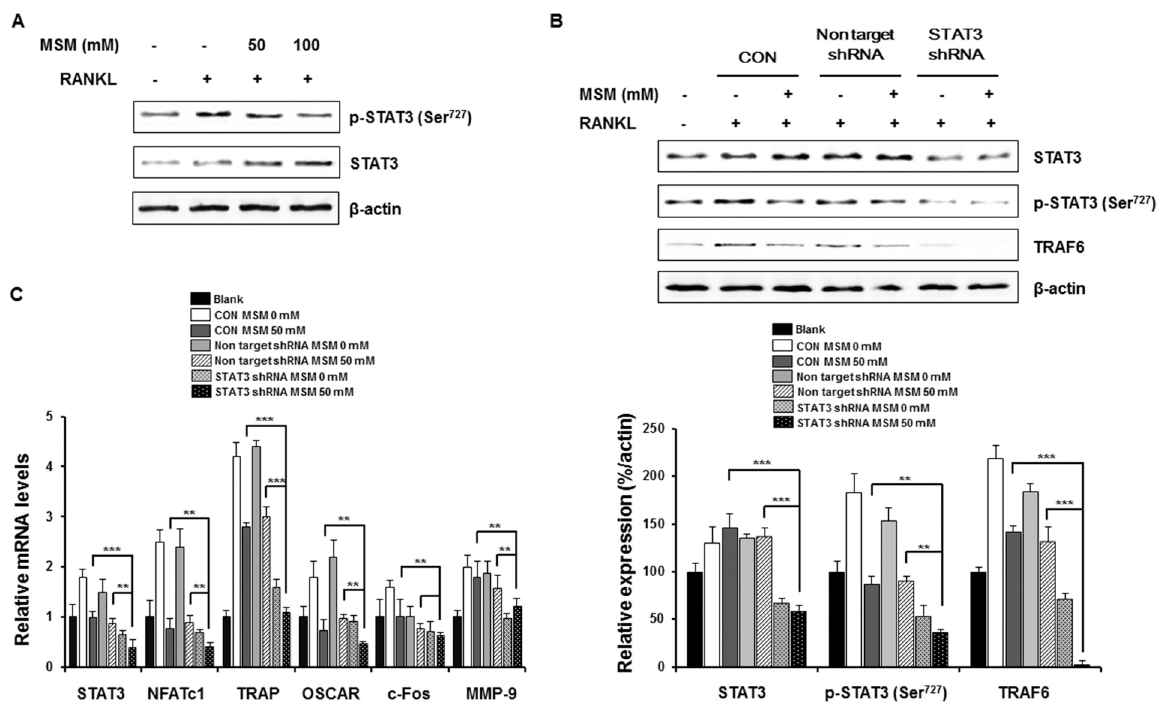
Fig 4. MSM attenuates RANKL-induced osteoclastic marker gene expression by blocking STAT3. (A) RAW264.7 cells were incubated with or without MSM for 1 h and then either exposed (or not) to RANKL (100ng/ml) for 10 min. Cell lysates were then blotted and immunostained with p-STAT3 and STAT3 antibodies. (B) RAW264.7 cells were transfected with STAT3 shRNA or a non-targeting shRNA for 48 h, then stimulated with RANKL (100 ng/ml) for 10 min. Cell lysates were prepared for western blot with antibodies as indicated. The relative levels of protein were determined using densitometry and normalized to β -actin. (C) RAW264.7 cells were transfected as in (B) and then stimulated with RANKL (100 ng/ml) for 24 h, with total RNA isolated using Qiagen. Expression of osteoclastic marker genes and STAT3 were examined using real-time PCR with GAPDH used as an internal control. Data shown are representative of three independent experiments. Asterisks indicate a significant increase by t-test ( ** p < 0.01, *** p < 0.001).